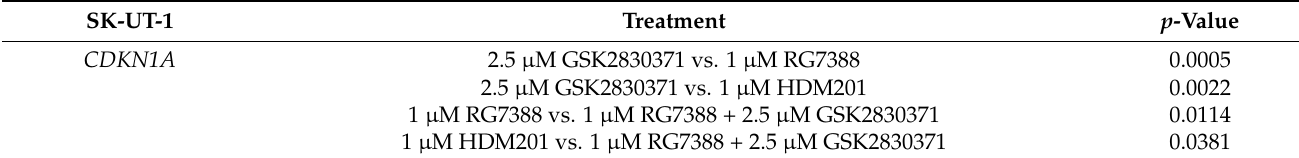
Table A4. All statistically significant fold changes in mRNA expression of selective p53 transcriptional targets, as determined by a two-way ANOVA with Tukey’s post hoc test for multiple comparisons between SK-UT-1 cells when treated with RG7388/HDM201 inhibitors and GSK2830371 as single agents or in combination for 6